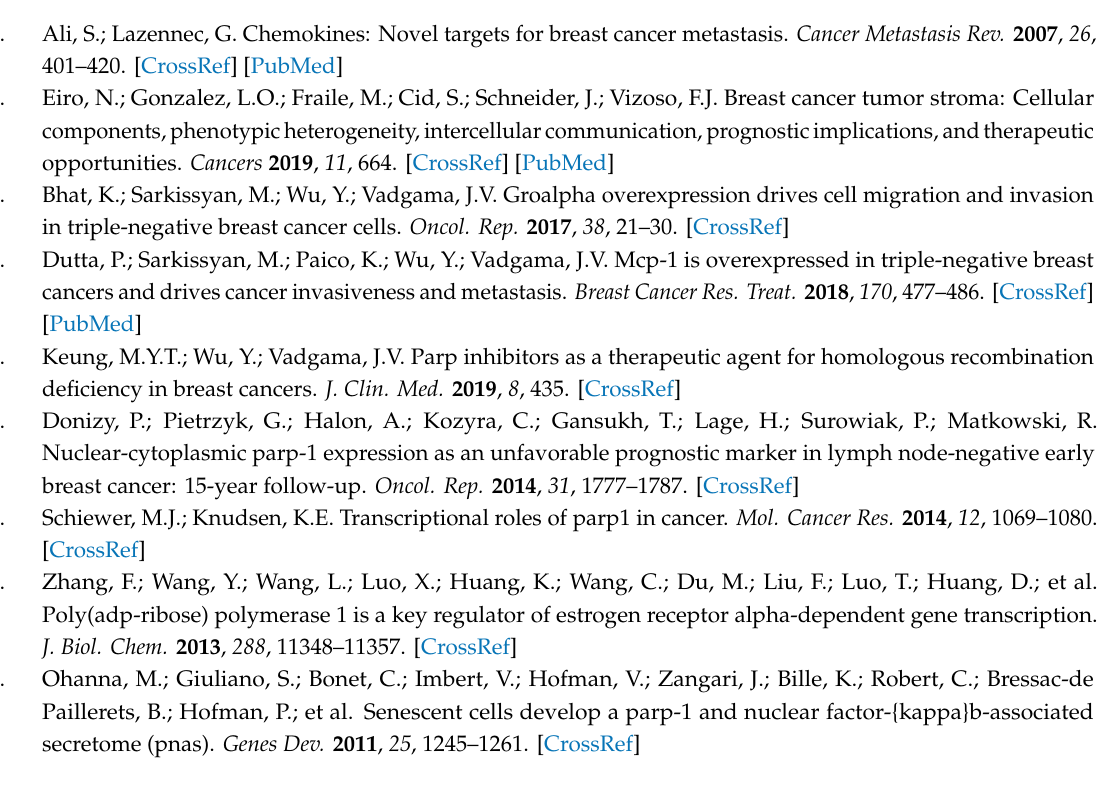
Figure S1: Overnight treatment with PJ34 does not cause significant apoptosis, Figure S2: PARP1 inhibition or knockdown a ff ects inflammatory and oncogenic pathways, Figure S3: GSEA leading-edge analysis on significant Gene sets from PJ34-PARPi with 656 overlapping genes, Figure S4: Downregulation of CCL2 upon PARP1 inhibitor Treatment in BRCA negative TNBC cells, Figure S5: PARP1 localization across the CCL2 gene locus on chromosome 17, Figure S6: PARP1 inhibition reduces nuclear P65, Figure S7: Expression of PARP1, P65, CCL2 from TCGA breast cancer dataset, Figure S8: Enlarged images of Figure 5A,C, Figure S9: Whole western blots in Figures 1–3, Figure S10: Whole western blots in Figures 4 and 5, Figure S11.Whole western blots in Figure S6, Figure S12: Enlarged view of Figure 1C Boyden chamber assay, Table S1: Gene lists for the whole transcriptome